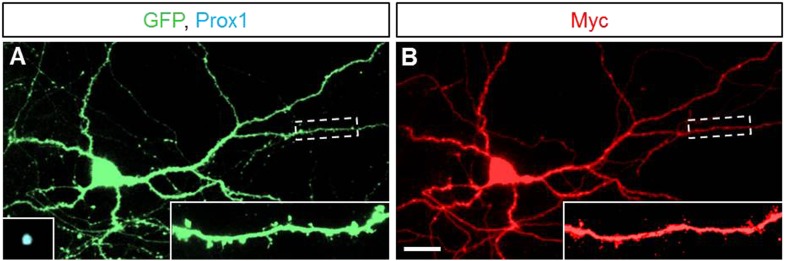
Sema5A is localized to neurites in dissociated hippocampal neurons.(A and B) Representative images of primary hippocampal neurons transfected with GFP and 6x-myc-Sema5A plasmid DNA. At DIV21, cultures were labeled with anti-GFP (green), anti-prox1 (blue, small insert in A), and anti-myc (red).